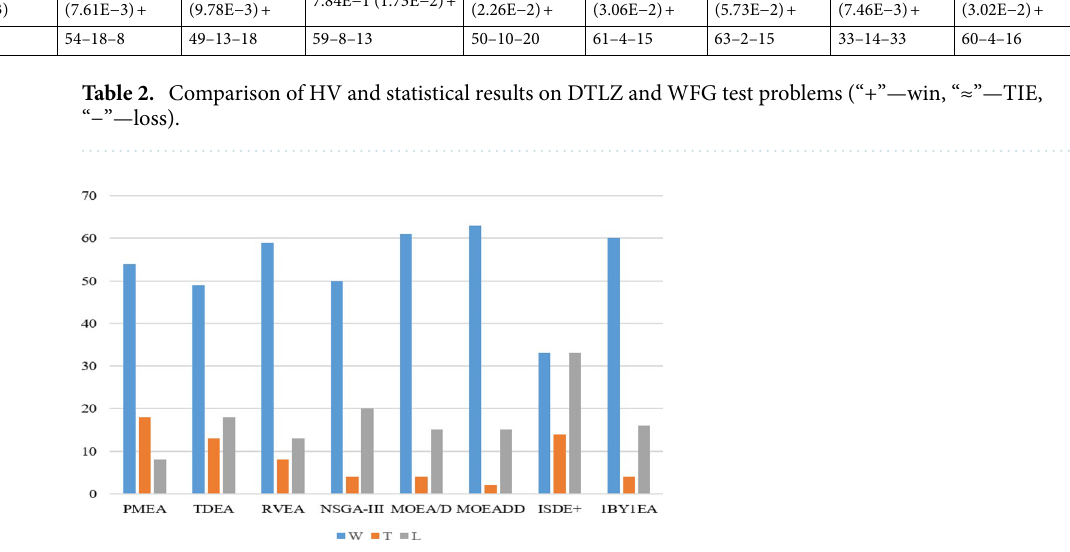
Figure 3. Performance comparison of HS-MOEA with the state-of-the-art